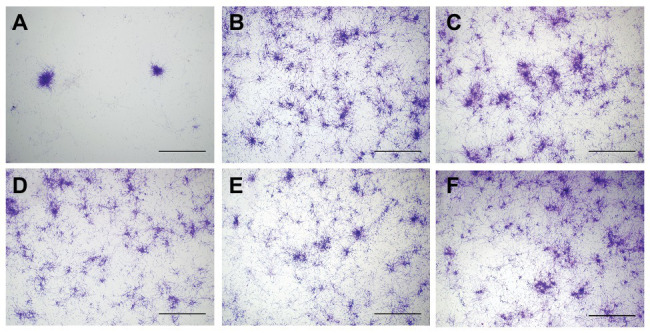
C. albicans biofilm morphology at 24 h after aPDT(×40). (A) 0.5% HAL ES, (B) 5% ALA, (C) 0.5% ALA, (D) 0.5% HAL, (E) blank ES, and (F) control. Bars: 100 μm.